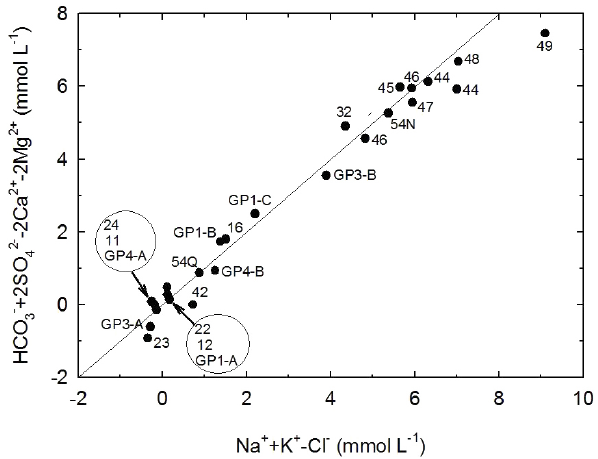
Figure 6. The relationship between deficit of Ca 2 + and Mg 2 + ions with respect to the sum of HCO − and SO 2 − ions and the excess 3 4 of Na + and K + ions over the Cl − ions in groundwater samples representing the part of the Neogene aquifer located in the study area and the shallow Quaternary aquifer in the area of Wielkie Błoto Figure 7. Piper diagram representing chemistry in water samples fen (see Table 2). collected in the study